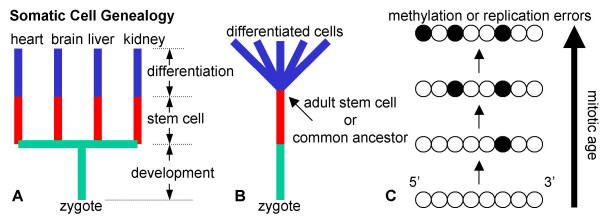
A human somatic cell tree. A: Every cell has a genealogy that starts with the zygote and ends with its present day phenotype. The genealogy of a differentiated cell can be divided into three phenotypic phases – development from the zygote, a stem cell phase, and differentiation. B: Stem cells are common ancestors in a somatic cell tree. The zygote is the ultimate common ancestor, and adult stem cells are more recent common ancestors of differentiated cells. C: Replication errors record cell division or genome duplication. Illustrated are a 5' to 3' series of eight CpG sites that are initially unmethylated (open circles). Random replication errors may accumulate during cell division such that some CpG sites become methylated (filled circles). The greater the numbers of divisions since the zygote (mitotic age), the greater the number of errors or methylation (molecular clock hypothesis).